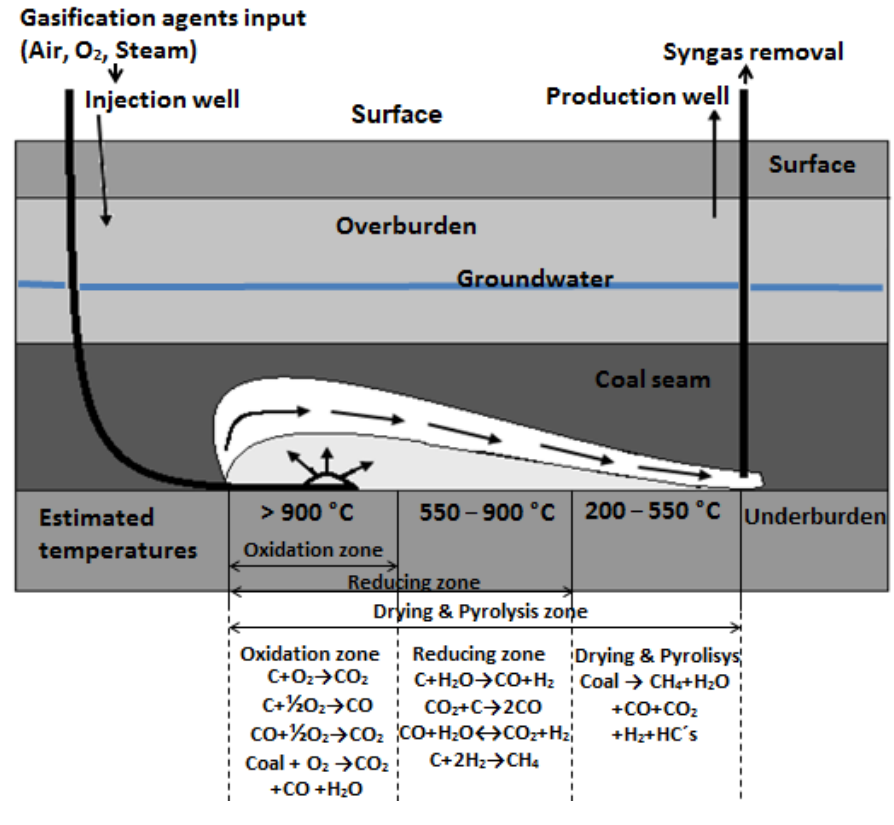
Figure 1. The principle of UCG.